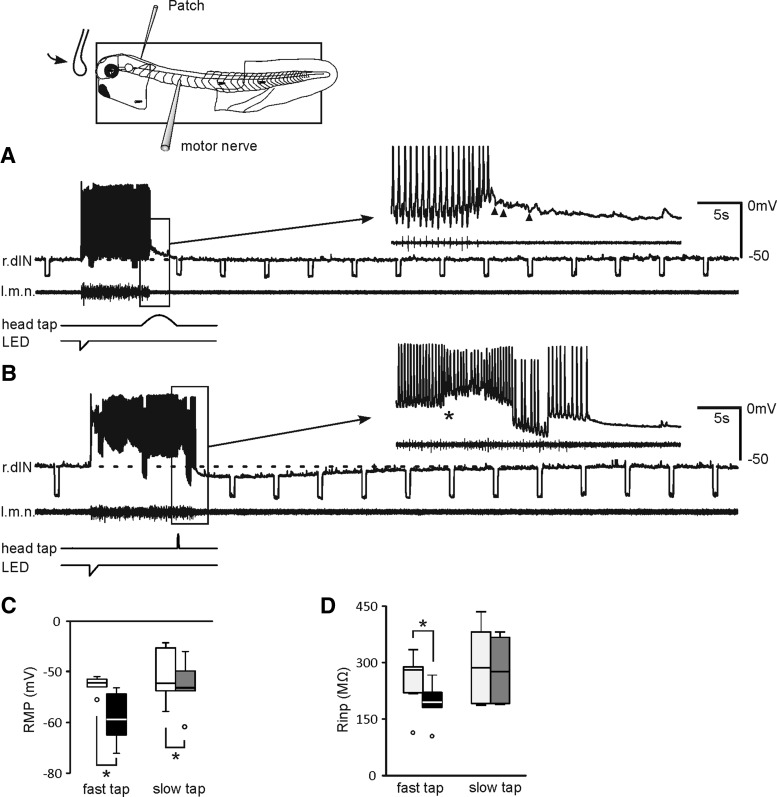
Responses of dINs to head taps. A, A slow tap at 0.125 Hz ends swimming (motor nerve, m.n.) and evokes a mixture of EPSPs and IPSPs (arrow heads in inset) in a dIN on the right side of the hindbrain (r.dIN). B, A fast tap at 2.5 Hz briefly excites another dIN in the right side hindbrain (*) then stops swimming with delayed, prolonged inhibition in the RMP and decreased Rinp (test steps: −100 pA). C, D, RMPs and Rinp in control (unfilled columns) and at the trough period of inhibition after taps. While slow taps at 0.125–0.25 Hz decrease RMPs in 8 dINs (from −52.2 ± 1.9 to −54.4 ± 1.9 mV, gray) without changing the Rinp, fast taps at 2.5–10 Hz in 6 dINs decrease RMPs from −52.6 ± 0.7 to −59.1 ± 2 mV with a reduction in the Rinp by 29.6 ± 8.5% (black, *p < 0.05, paired t test or related sample Wilcoxon signed rank test). Dashed lines indicate RMP in A, B. Inset on the top shows experimental setup.